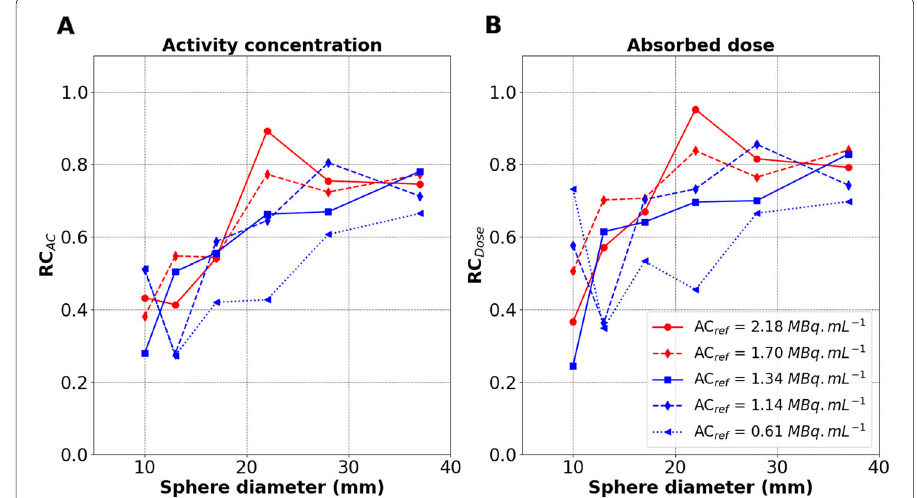
Fig. 6 Recovery coefficients against sphere diameter for varying AC ref over 6 days. A RC AC . B RC Dose . Reconstructions were performed using